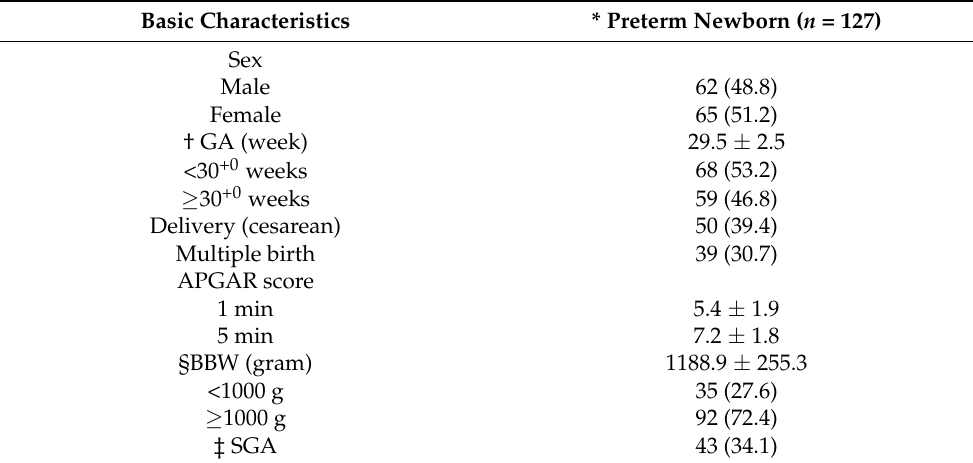
Table 1. Basic characteristics at birth for the preterm newborns enrolled in the NICU of Kaohsiung Medical University